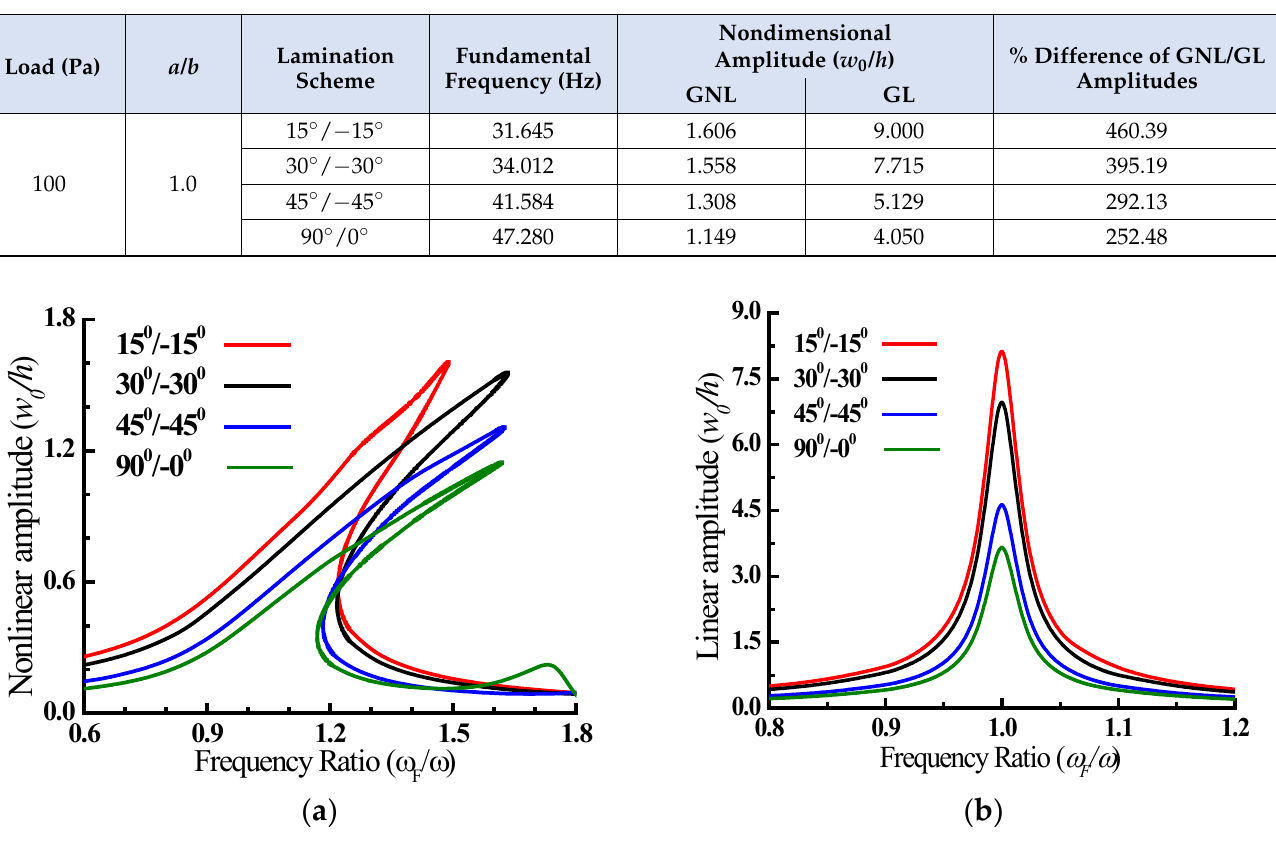
Figure 2. Nonlinear ( a ) and linear ( b ) variation of amplitude ( w 0 /h ) at the centre of the plate for different forcing frequency ratio. Peak amplitude reduces with the increasing fiber angle in both linear and nonlin- ear analyses for the two-layered angle-ply plate because of greater lamination scheme- generated bending–stretching coupling, leading to higher rigidity. The comparison of peak displacement amplitude of linear and nonlinear analysis shows that linear analysis peak displacement amplitude is considerably greater than the nonlinear analysis. The comparison of linear and nonlinear peak displacement amplitude reveals that the percent- age difference between the two decreases with the increase in fiber angle, and the linear peak amplitude is 5.6, 4.9 and 3.9 times the nonlinear peak amplitude for the two-layered angle-ply plate with fiber angles of 15 ◦ / − 15 ◦ , 30 ◦ / − 30 ◦ and 45 ◦ / − 45 ◦ , respectively. The nonlinear dynamic behaviour of the plate is evaluated by obtaining the displace- ment time history of the plate’s centre referring to the forcing frequency ratio of peak amplitude in Figure 2’s nonlinear response, which is shown in Figure 3 together with the phase-plane plot at this moment. The steady-state response history shows that the positive/negative half-cycle amplitudes will have nearly equal intervals in tension and compression for all fiber angles evaluated. The asymmetricity in the phase-plane plot implies strong higher harmonic participation, whereas the symmetric phase-plane plots imply limited higher harmonic